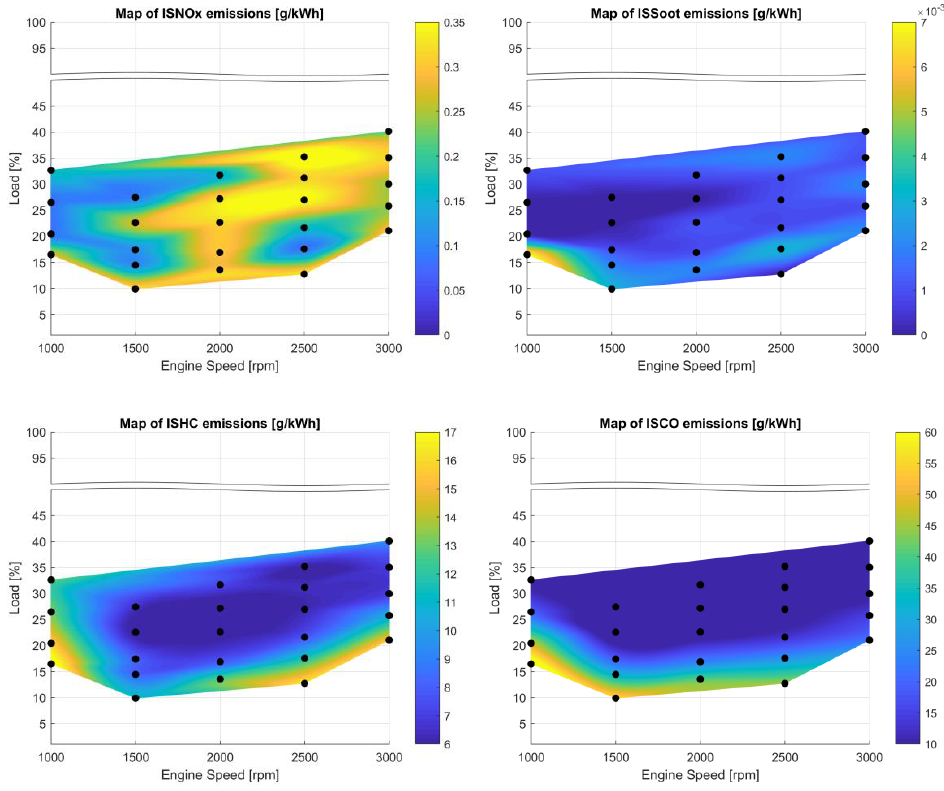
Figure 4. Engine-out emissions in the RCCI portion of the map.